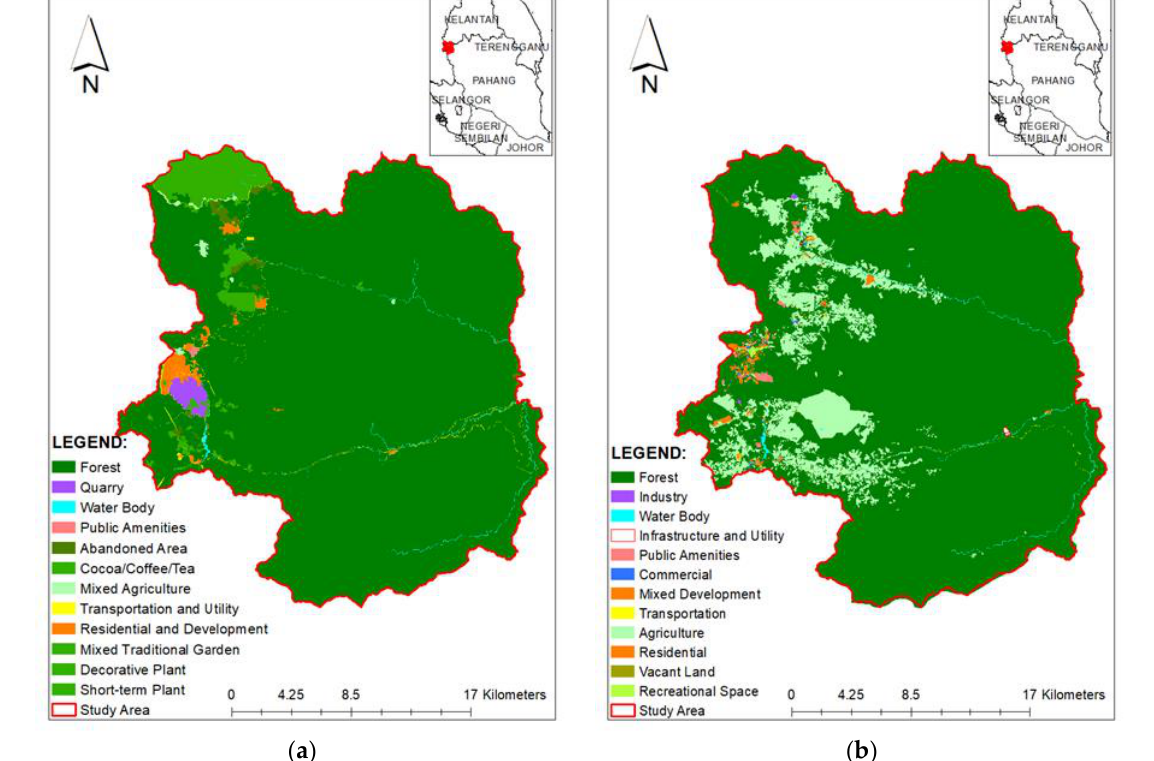
Figure 2. Land-use activities of Cameron Highlands for ( a ) the year 2015 [21] and ( b ) the year 2018 [22]. Table 1. Area for each land-use activities in Cameron Highlands.